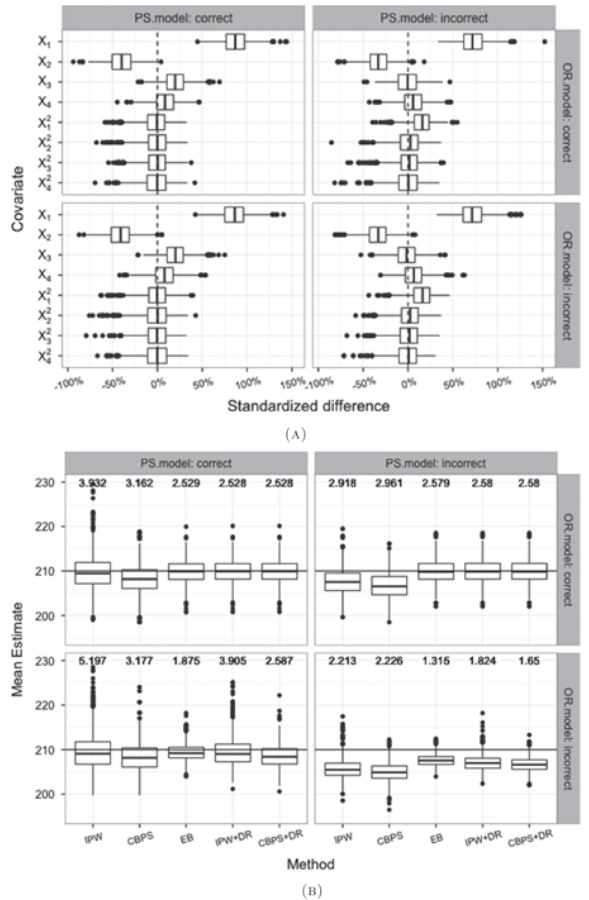
Figure 2: Kang-Schafer example: sample size n = 200. Both propensity score model and outcome regression model can be correct or incorrect, so there are four scenarios in total. We generate 1,000 simulations in each scenario. (a) Covariate imbalance before adjustment. (b) Mean estimates. The methods are: Inverse Propensity Weighting (IPW), Covariate Balancing Propensity Score (CBPS), Entropy Balancing (EB), and doubly robust versions of the first two (IPW+DR, CBPS+DR). Target mean is 210 and is marked as a black horizontal line to compare the biases. Numbers printed at Y = 230 are the sample standard deviations to compare